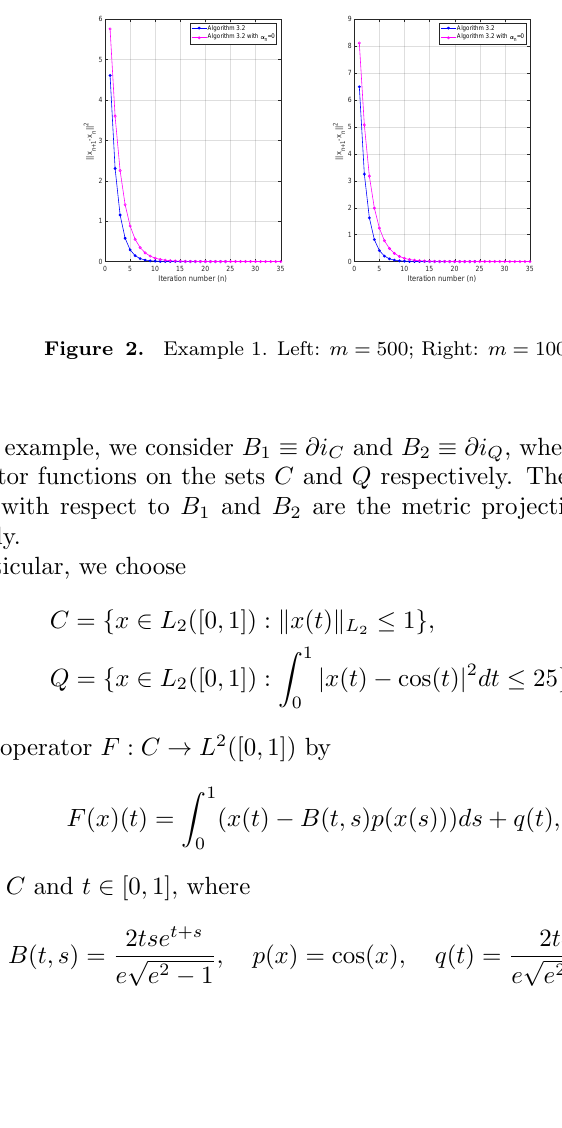
Algorithm 3.2 Algorithm 3.2 with